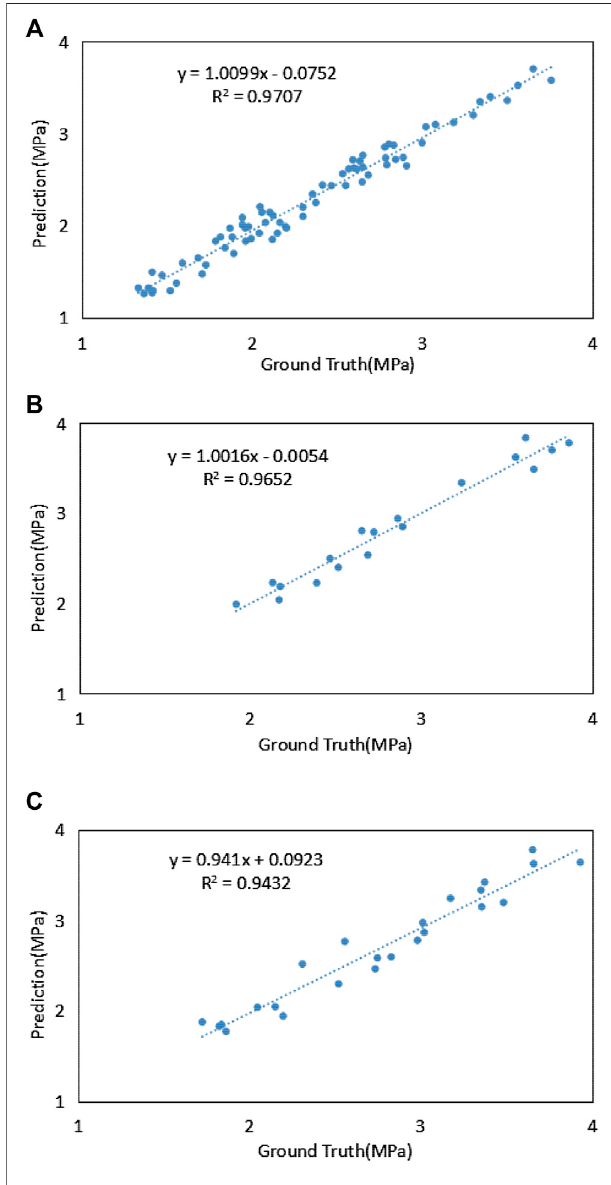
FIGURE 4 | Correlation between predicted and experimental tensile strengths: (A) training dataset, (B) validation dataset, and (C) testing dataset of